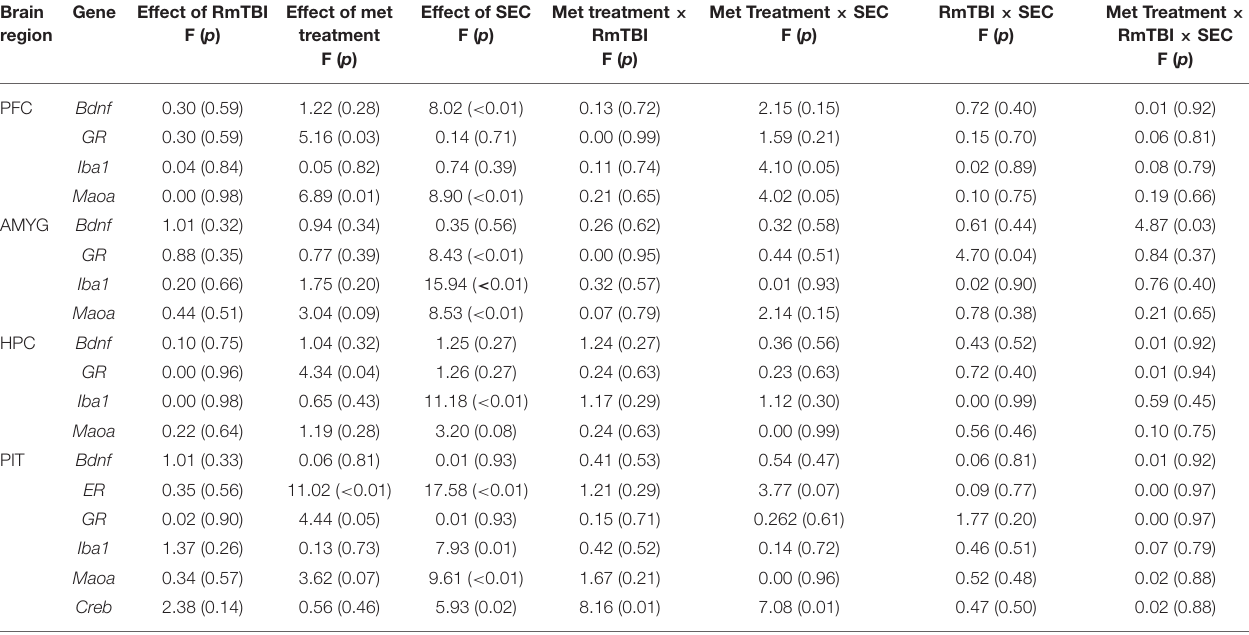
TABLE 2 | Changes in gene expression in the pfc, amyg, hpc, and pit after rmtbi, metandienone treatment, and SEC. Brain Gene Effect of RmTBI region F ( p )